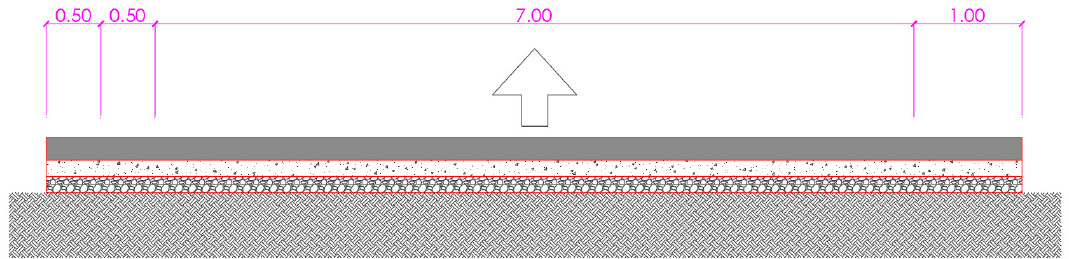
Figure 7. Cross section of circulatory roadway (unit of measure: m).